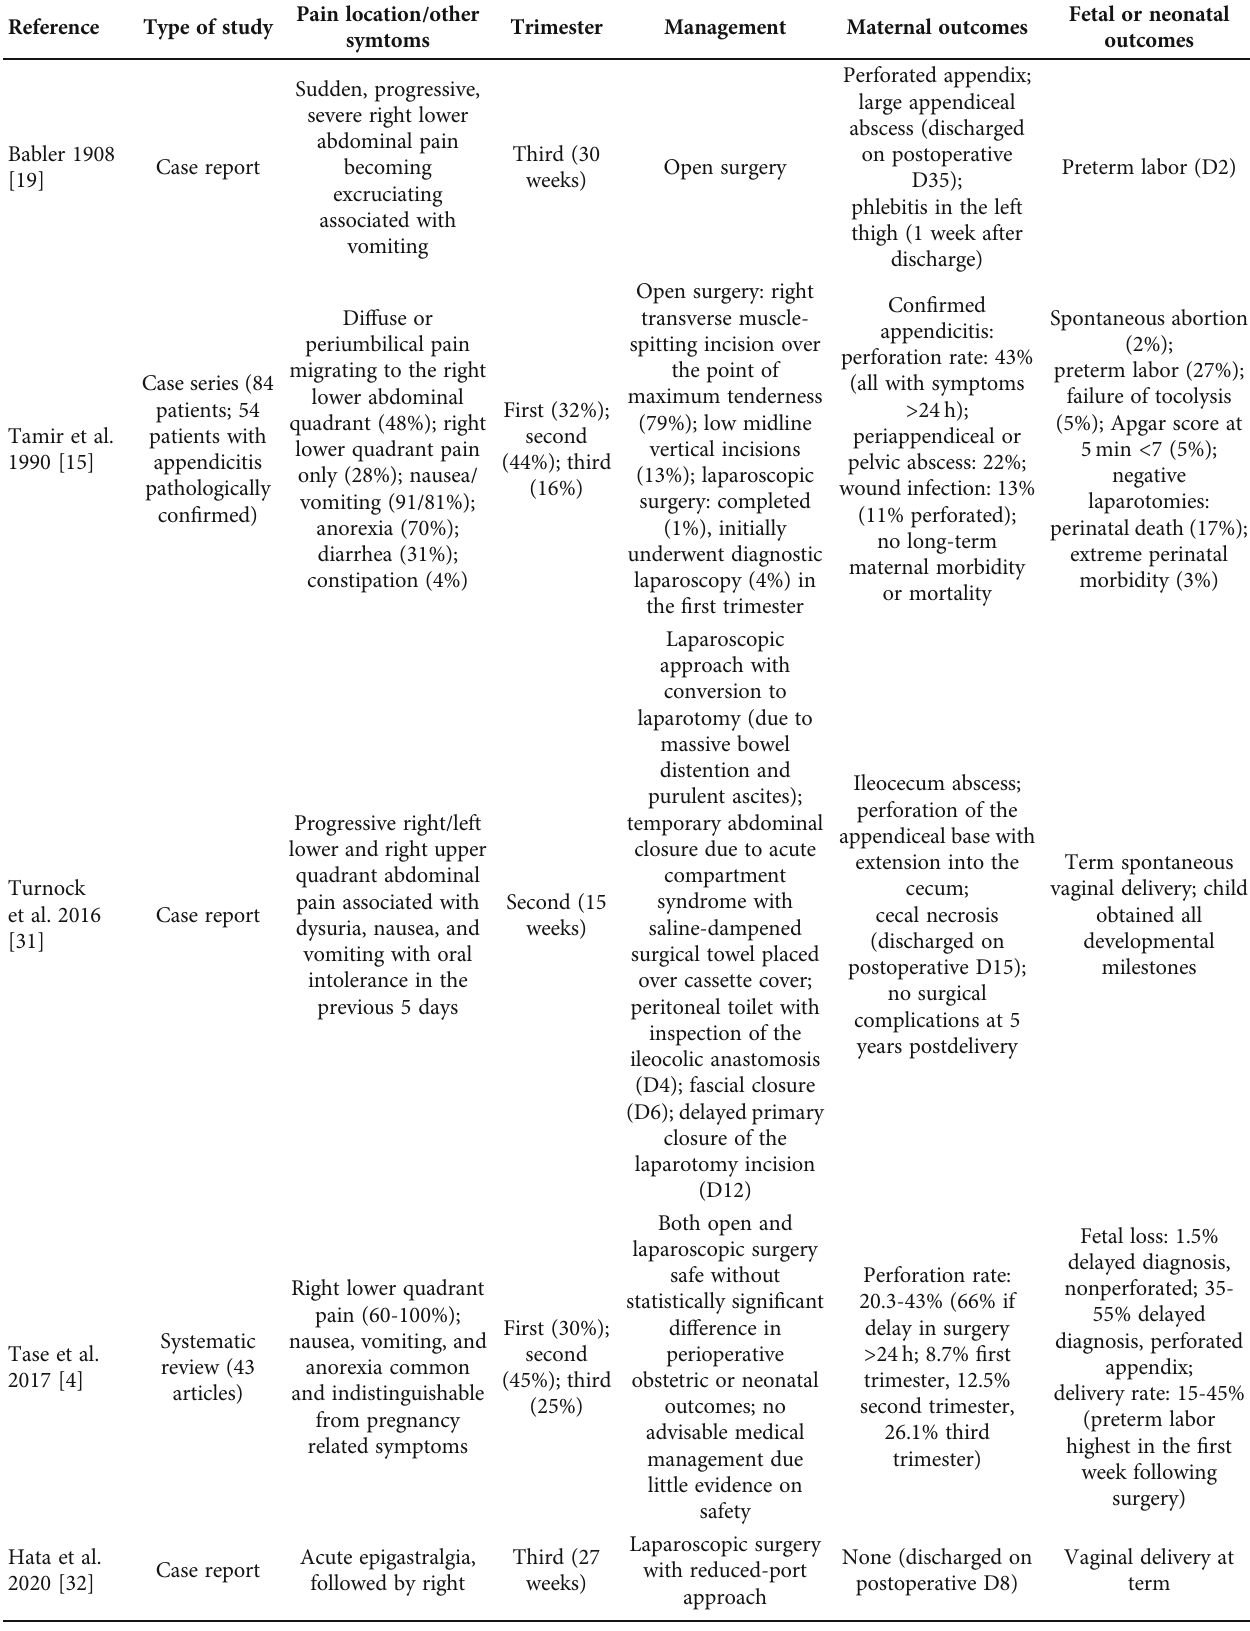
Table 1: Comparative table of previous studies reporting appendicitis in